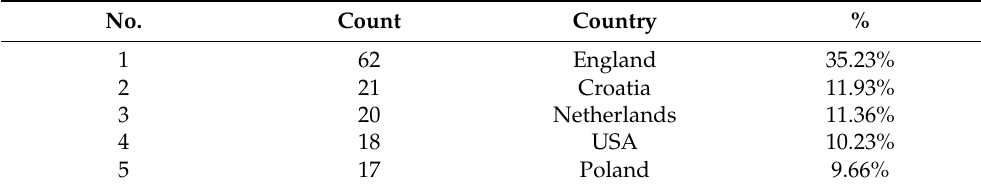
Table 5. Top five countries according to their number of journal papers.